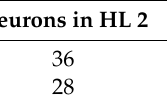
Table 4. Comparison of ε p − min for different training